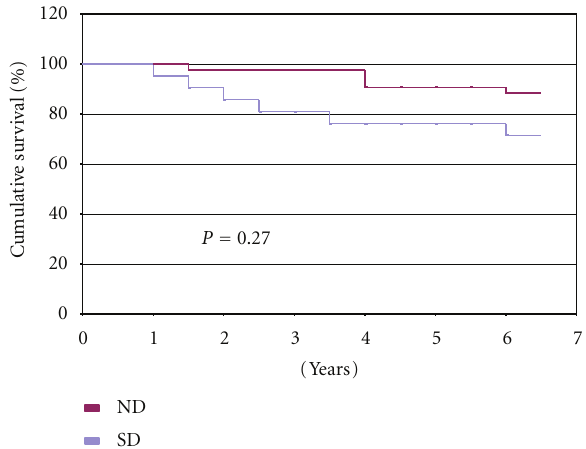
Figure 4: Kaplan Meier renal allograft survival curves for kidneys from living donors with a history of tobacco use (SD) and those with no history of tobacco use (ND). Statistical significance between mean survival times is assessed using the Mantel-Cox logrank test.